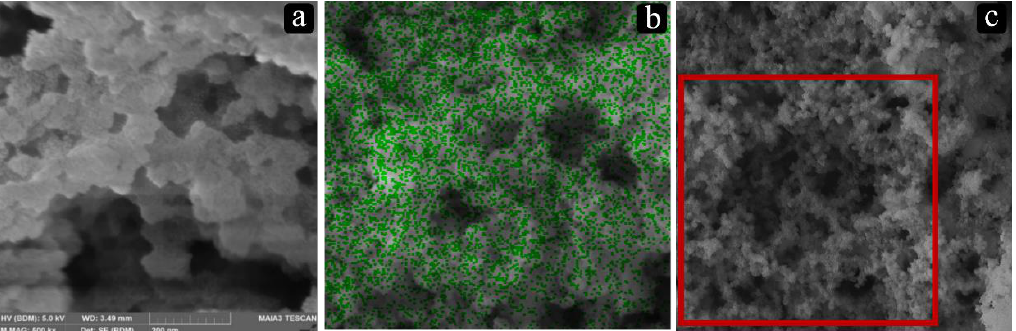
Figure 3. FESEM-EDX image of the Cab-O-Sil-based SiO 2 /Co(OH) 2 nanocomposite catalyst prepared at 70 °C ([SiO 2 ] = 1 wt%, [Co] = 6 mM) ( a ) with elemental mapping of Co on the catalyst. ( b ) Co atoms are denoted by green dots. ( c ) The EDX-selected area for elemental analysis is